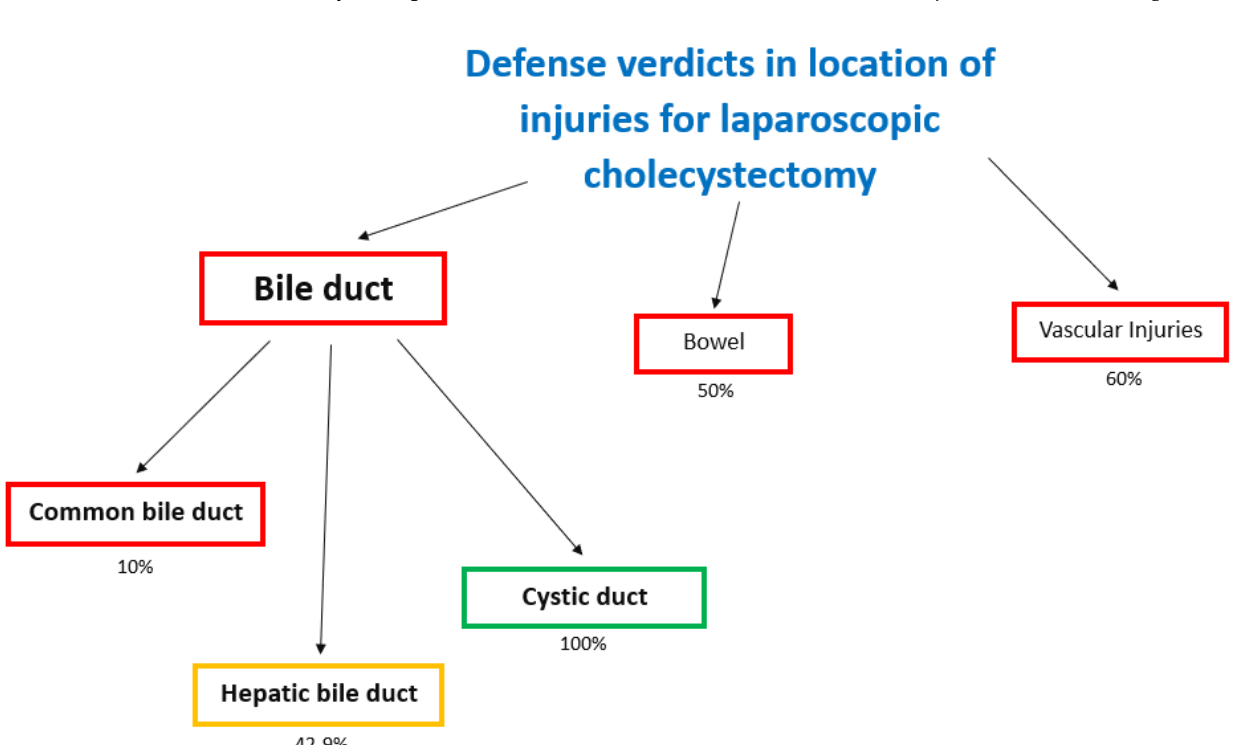
Figure 14. Flowchart of causes of defense verdicts in location of injuries for laparoscopic cholecystectomy. Other uncommon locations injured were bowel and vessels. The incidence of bowel injuries was 7 ± 4%. The rate of plaintiff verdicts and defense verdicts was the same